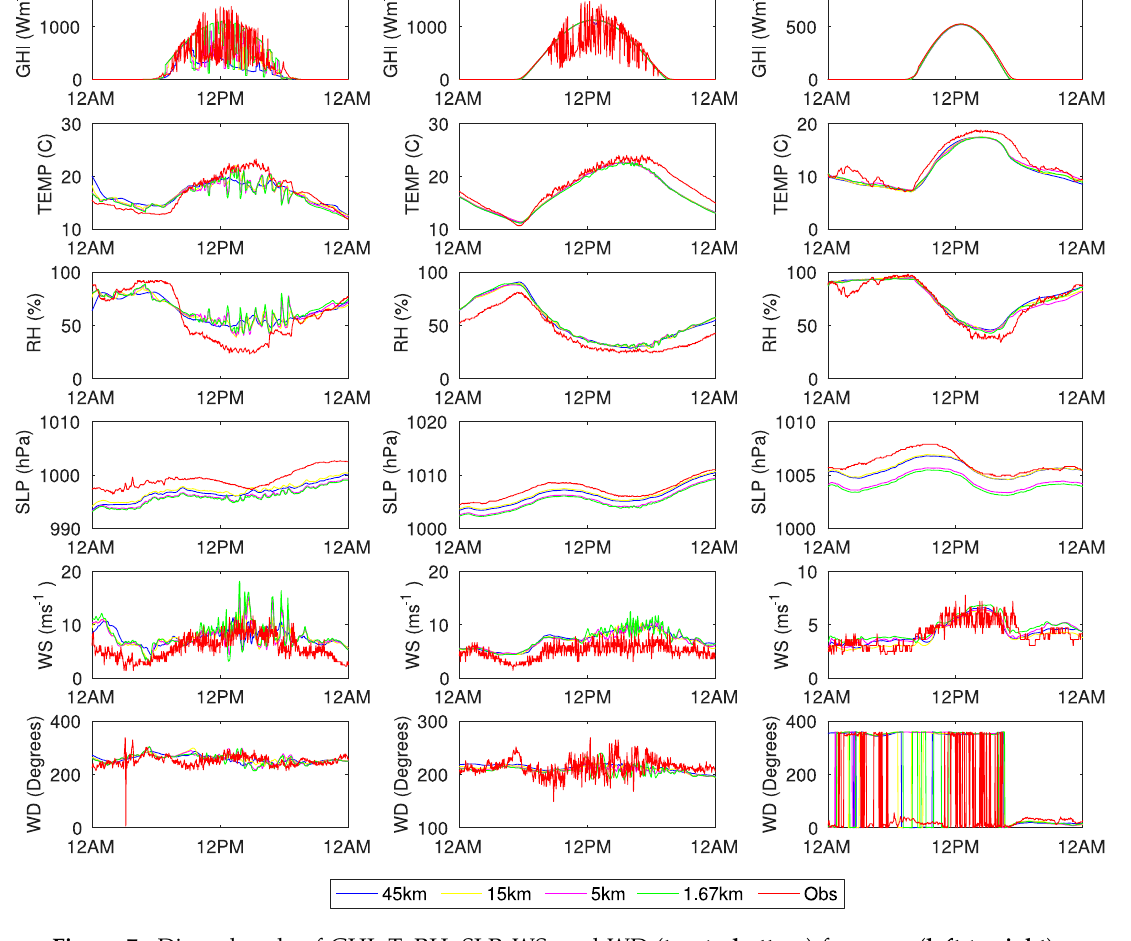
Figure 7. Diurnal cycle of GHI, T, RH, SLP, WS, and WD ( top to bottom ) for cases ( left to right ) described in Table 3.